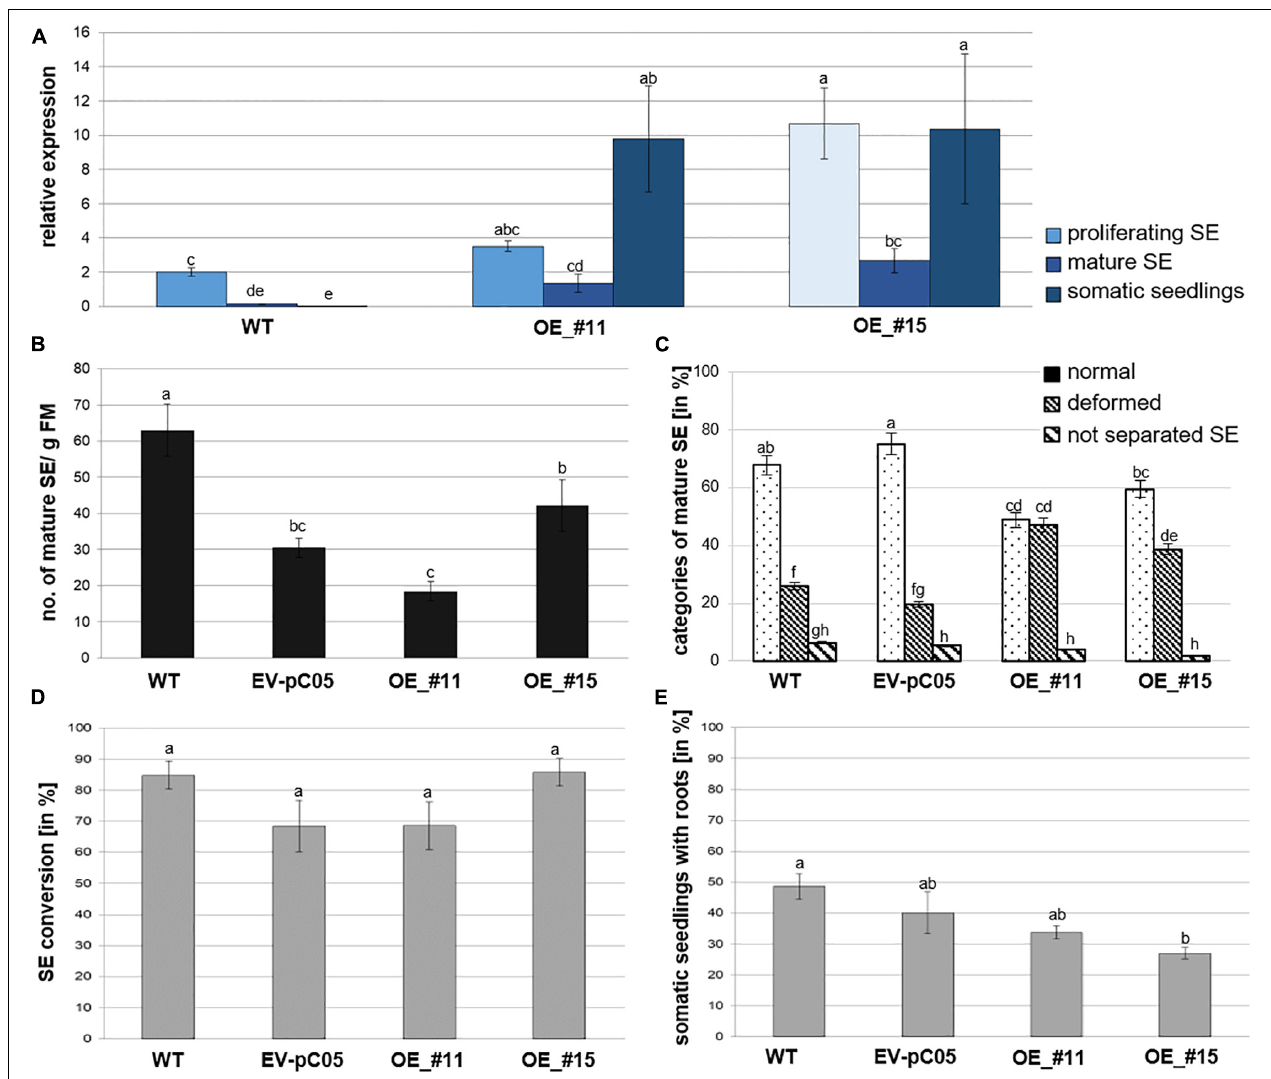
FIGURE 3 | Analysis of 35S::PpWOX2 overexpressing P. pinaster lines #11 and #15 (OE_#11 and OE_#15) and controls (WT, EV-pC05) with regard to PpWOX2 transgene expression following (A) RT-qPCR analysis, (B) SE maturation, (C) cotyledonary SE morphology, and (D) conversion (D) as well as (E) root development. (A) Relative expression of PpWOX2 in proliferating SEs, cotyledonary SEs, and somatic seedlings by RT-qPCR. (B) Number of cotyledonary SEs per g FM after 12–14 weeks in maturation medium. (C) Percentage of cotyledonary SEs ( n = 70) with different morphological phenotypes classified as normal, deformed, or not separated (fused) after 12–14 weeks in maturation medium. (D) Percentage of SEs ( n = 21) converted into somatic seedlings after 6 weeks in germination medium. (E) Percentage of somatic seedlings ( n = 21) with active root growth after 8 weeks in conversion medium. Embryos of control transgenic line EV-pC05 were transformed with pCAMBIA1305.2 (empty vector). WT line was the original PN519 line used for transformation experiment. Each value represents mean ± standard error obtained from three biological replicates and (A) 3, (D,E) 4, or (B,C) 7–10 technical replicates. Bars with different letters are significantly different (ANOVA, P <